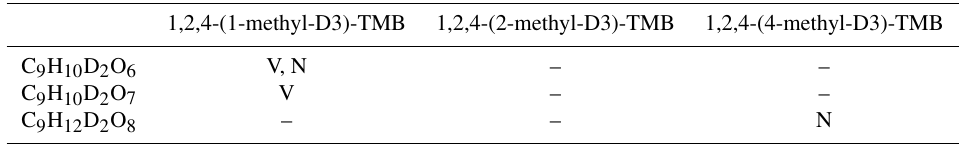
Table 3. Partially deuterated C 9 products observed by the Vocus PTR and/or the nitrate CI-APi-TOF. “V” and “N” denote observation by the Vocus PTR and nitrate CI-APi-TOF, respectively, whereas “–” means that the product was not observed by any